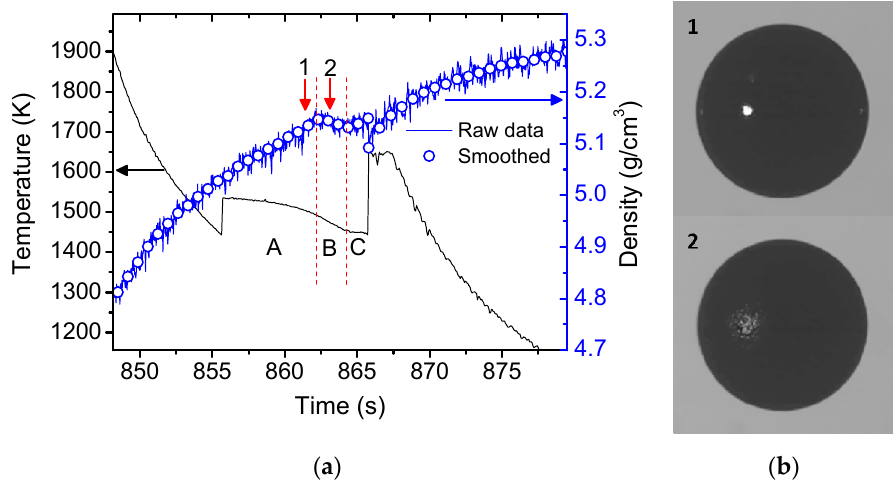
Figure 5. ( a ) Time-density and time-temperature profiles of a CoSi-62 at. % melt during solidification. The density shows a distinct behavior dependence on delay time. ( b ) Video images captured at A and B regions. The corresponding times to the images are 861.4 s and 863.1 s for points 1 and 2, respectively.